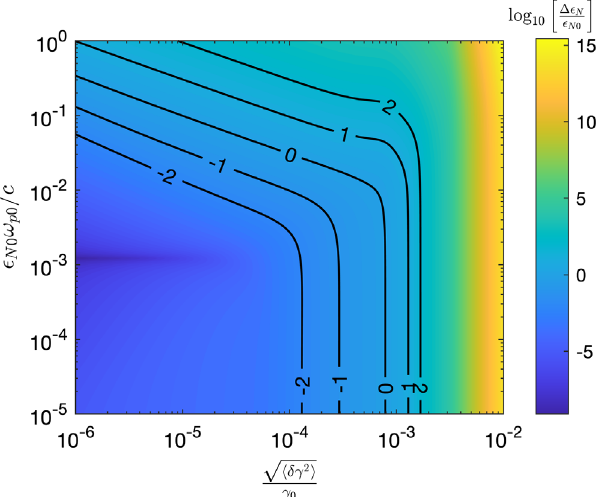
= ϵ through 85 accel- N N 0 . The colormap/ N 0 = ϵ N N 0